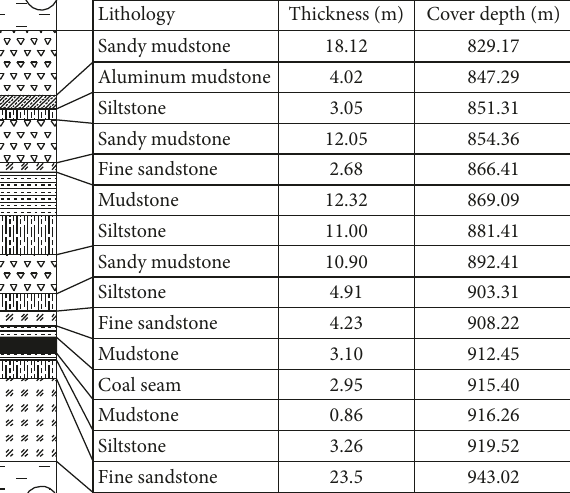
Aluminum mudstone